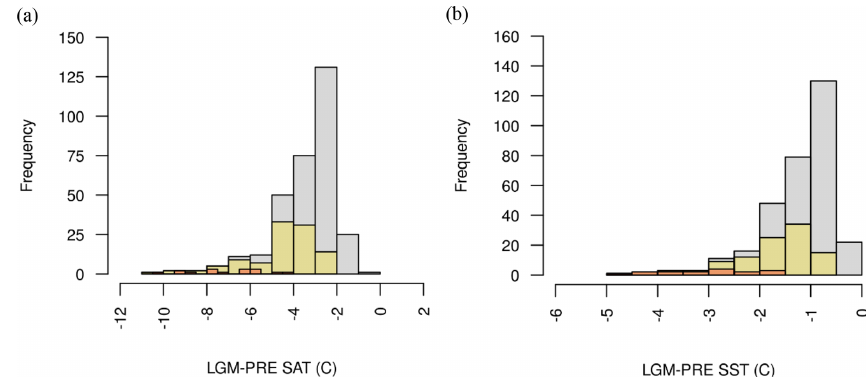
Figure 2. LGM change in surface air temperature and sea surface temperature (a–b)